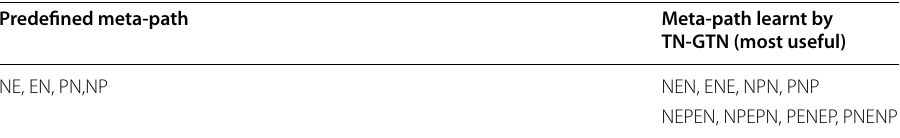
Table 4 Predefined meta-path and meta-path learnt by TN-GTN Predefined